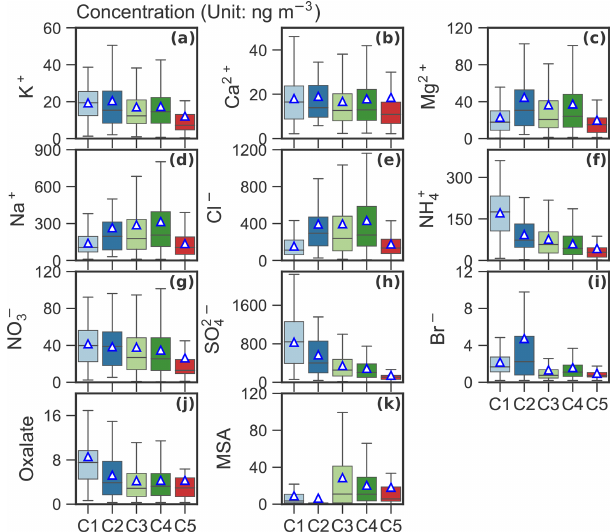
Figure 4. Box plot of mass concentration (unit: ngm − 3 ) of each chemical species for the identified clusters. The mean values are marked as triangles.